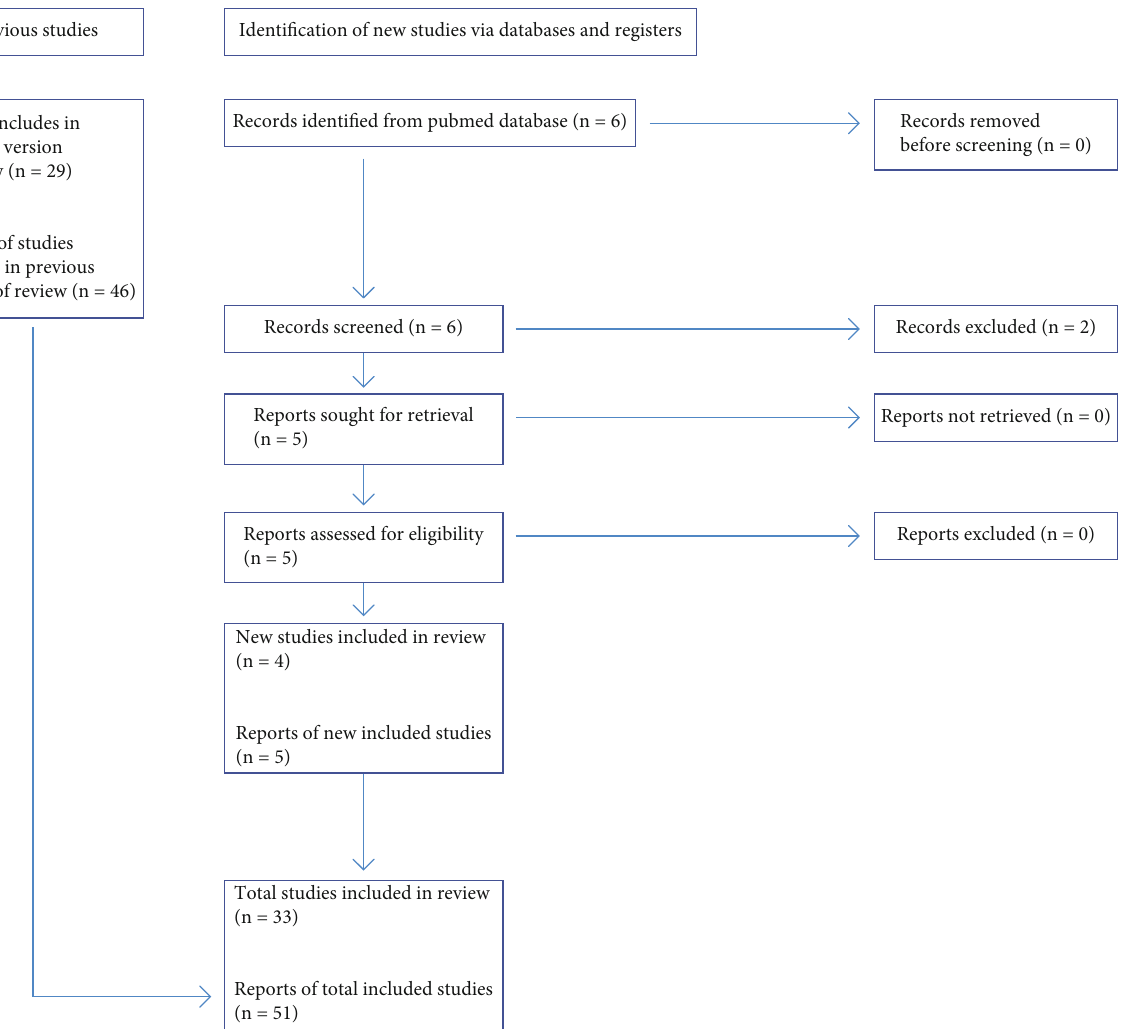
Figure 1: PRISMA 2020 fl ow diagram for updated systematic reviews